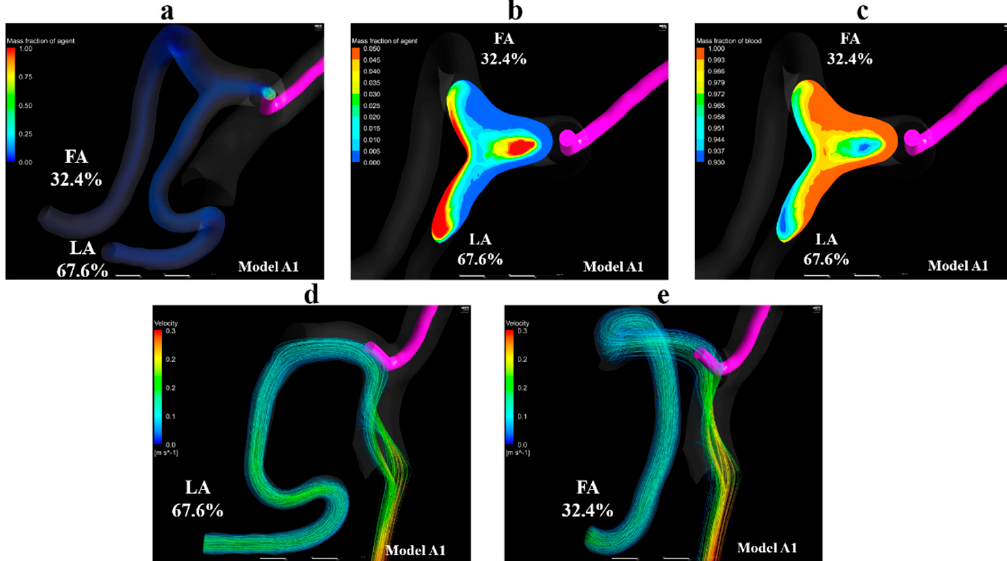
Figure 9. Volume-rendering image, contour plots, and streamlines in model A1. ( a ) Volume-rendering image of the mass fraction of agent in model A1, ( b ) contour plot of the mass fraction of agent in the linguofacial trunk in model A1, ( c ) contour plot of the mass fraction of blood in the linguofacial trunk in model A1, ( d ) streamlines toward the LA in model A1, ( e ) streamlines toward the FA in model A1. The number of figures shows the distribution rate of the agent. FA, facial artery; LA, lingual artery.